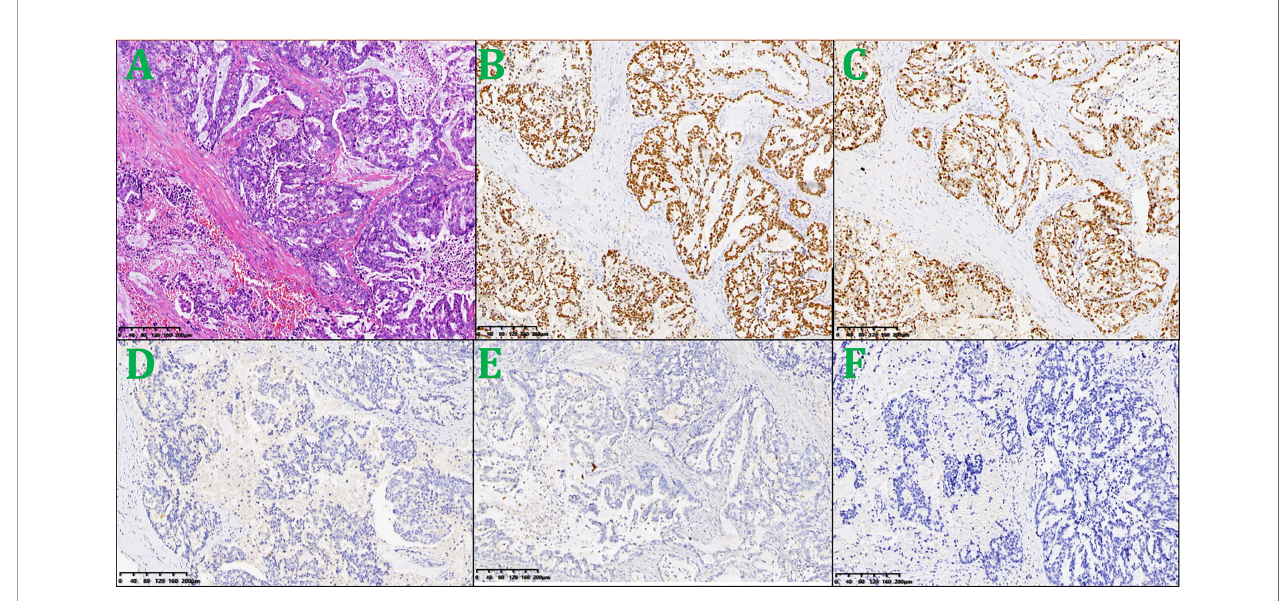
FIGURE 3 | Lesion biopsy specimen of the left supraclavicular lymph node. (A) HE × 100; (B) TTF-1× 100; (C) Ki-67 × 100; (D) Syn × 100; (E) P40 × 100; (F) PD- L1 ×